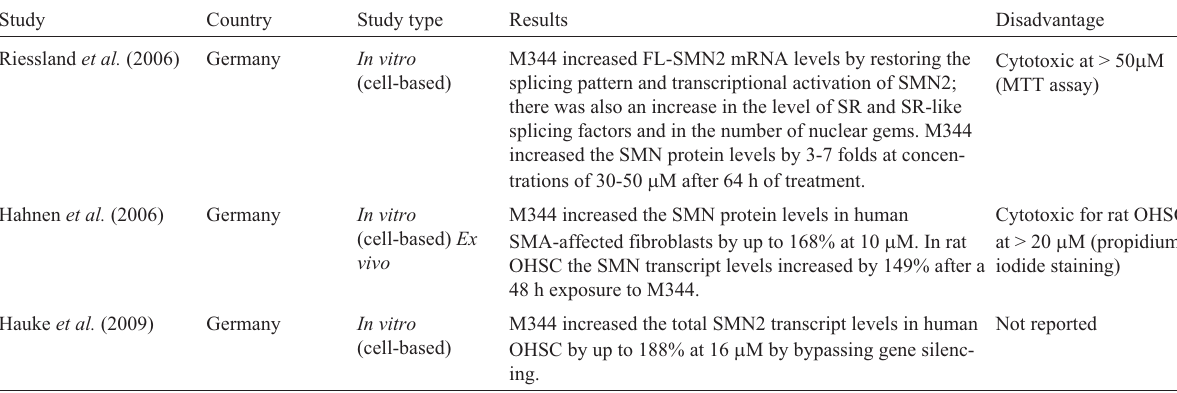
Table 4 - Summary of studies on benzamide M344 for the treatment of spinal muscular atrophy.